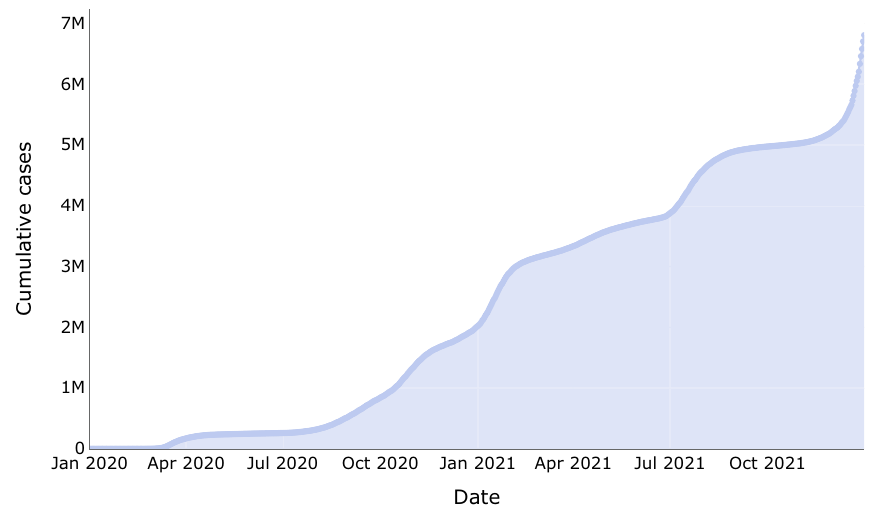
Figure 8. Cumulative COVID-19 confirmed cases in Spain since the start of the